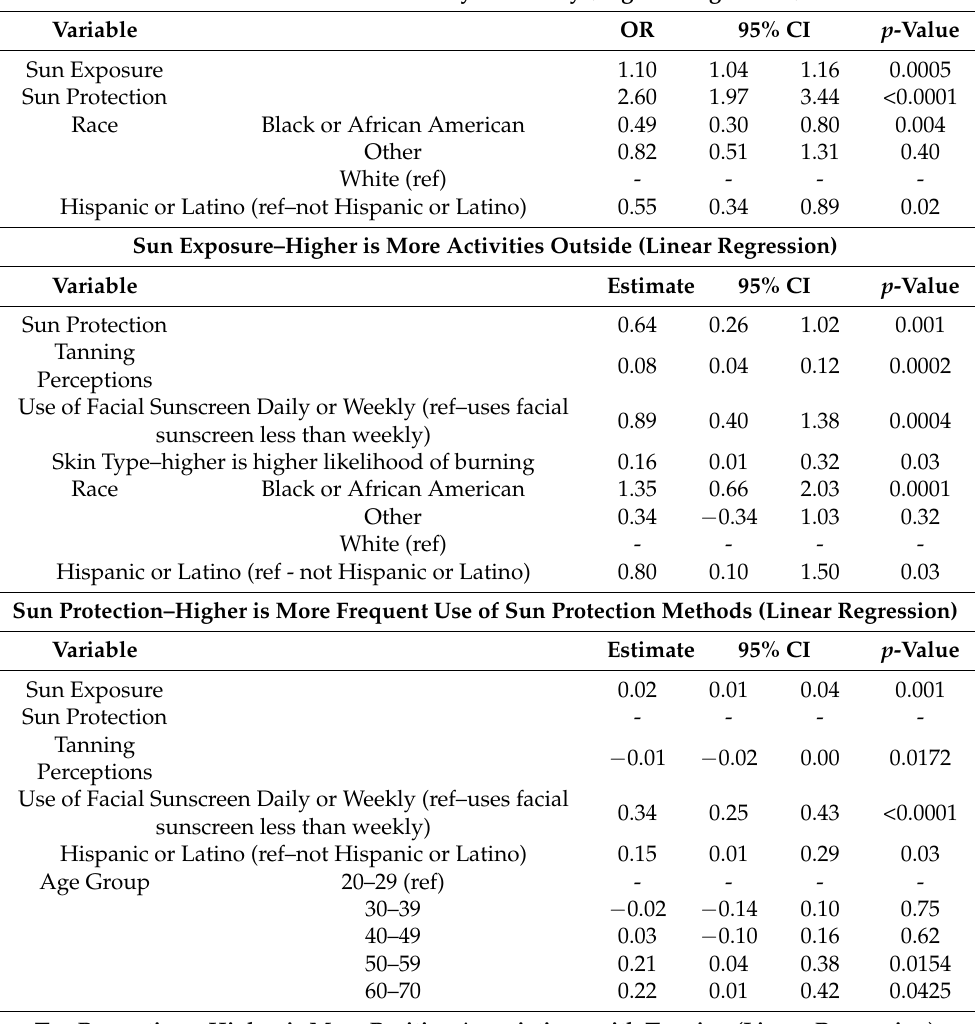
Table 5. Predictors of use of facial sunscreen, sun exposure, sun protection behaviors, and perceptions of tanning. Use of Facial Sunscreen Daily or Weekly (Logistic Regression) Variable OR Sun